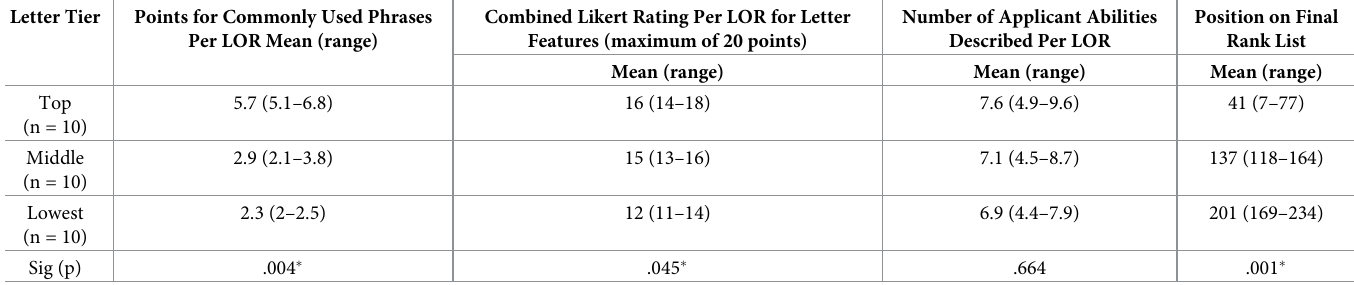
Table 3. Means and range scores for letter phrases, features and applicant abilities by rank tertile. Letter Tier Points for Commonly Used Phrases Combined Likert Rating Per LOR for Letter Per LOR Mean (range) Features (maximum of 20